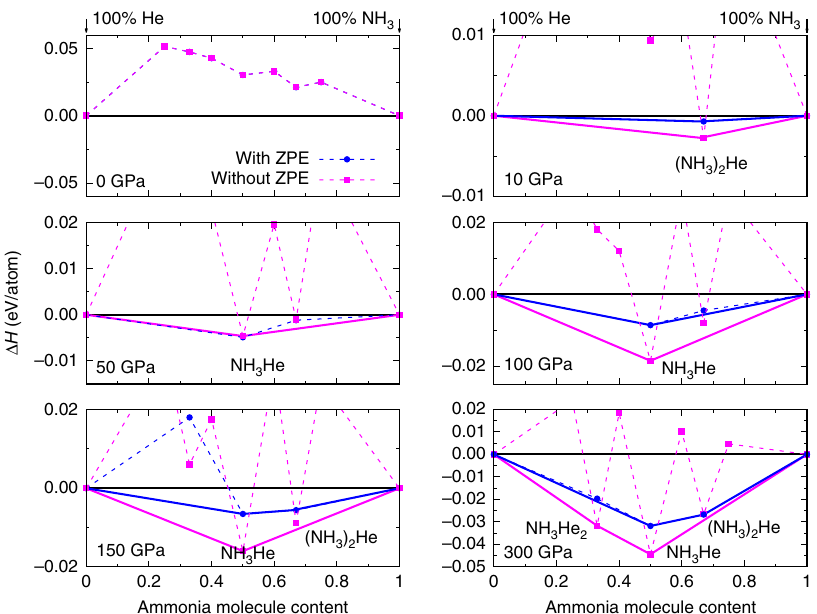
Fig. 1 Stability of the NH 3 -He system. Calculated enthalpies of formation ( Δ H ) of various NH 3 – He compounds with respect to decomposition into solid NH 3 and He at selected pressures. Convex hulls are shown as solid lines with (blue) and without (magenta) the inclusion of zero-point vibrational energies. Calculations adopted the P 2 1 /3 structure 41 at 10 GPa, the P 2 1 2 1 2 1 phase at 50 GPa, and the Pma 2 structure at 100, 150, and 300 GPa for NH 3 13 and hcp - He 42,43 at all pressures.